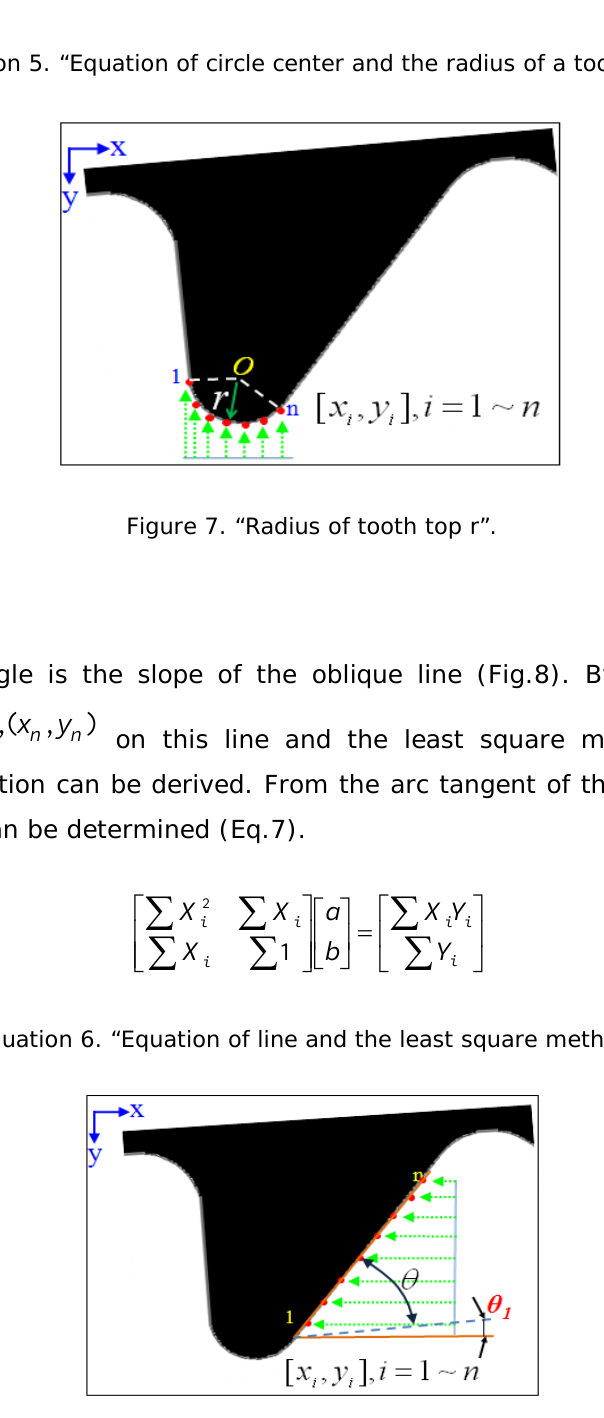
Equation 5. “Equation of circle center and the radius of a tooth top”.